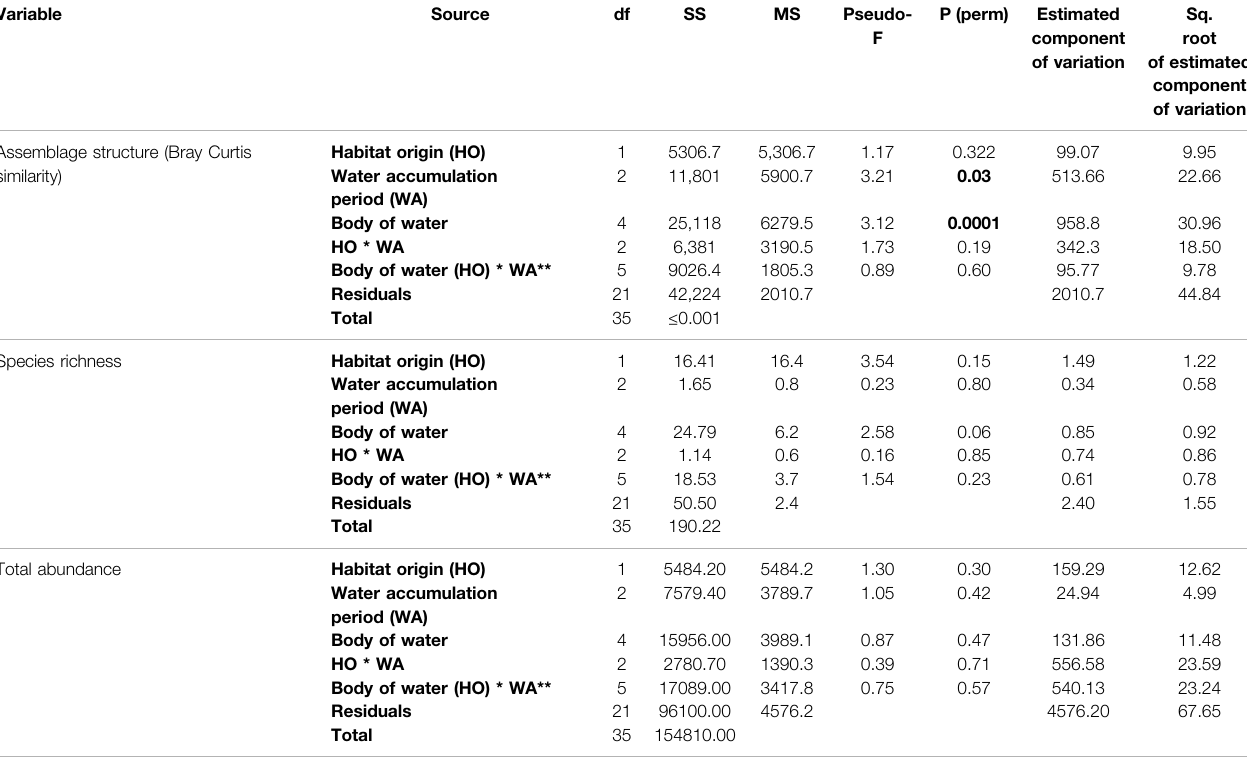
Bold values correspond to the factors that presented signi fi cant differences according to the model evaluated. The asterisk symbolizes the interaction between factors within the analysis of variance.